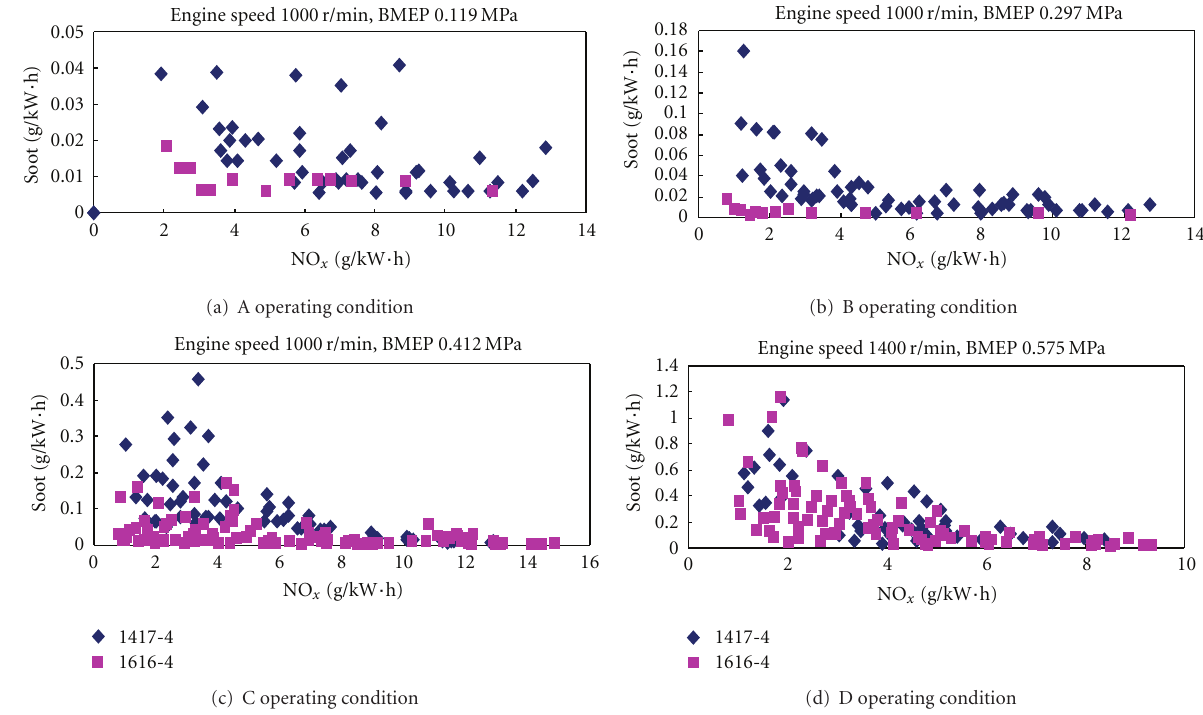
Figure 11: E ff ects of UMH nozzle holes number and diameter on NO x and soot